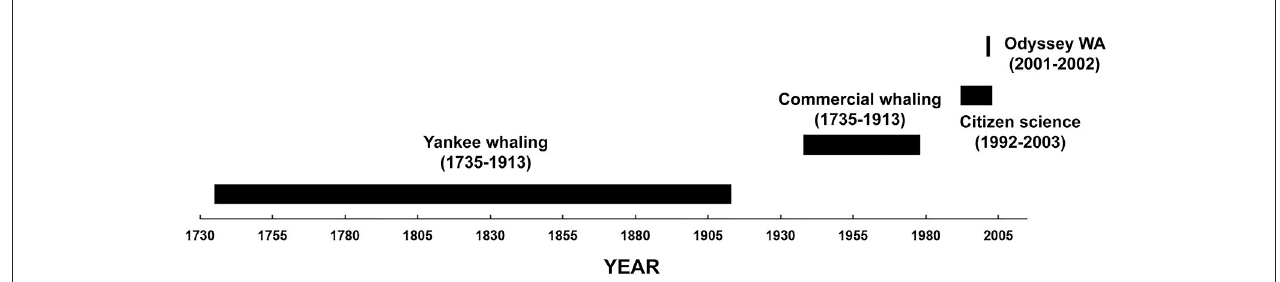
FIGURE 2 | Timeline of the data used in this study of sperm whale distribution off Western Australia.